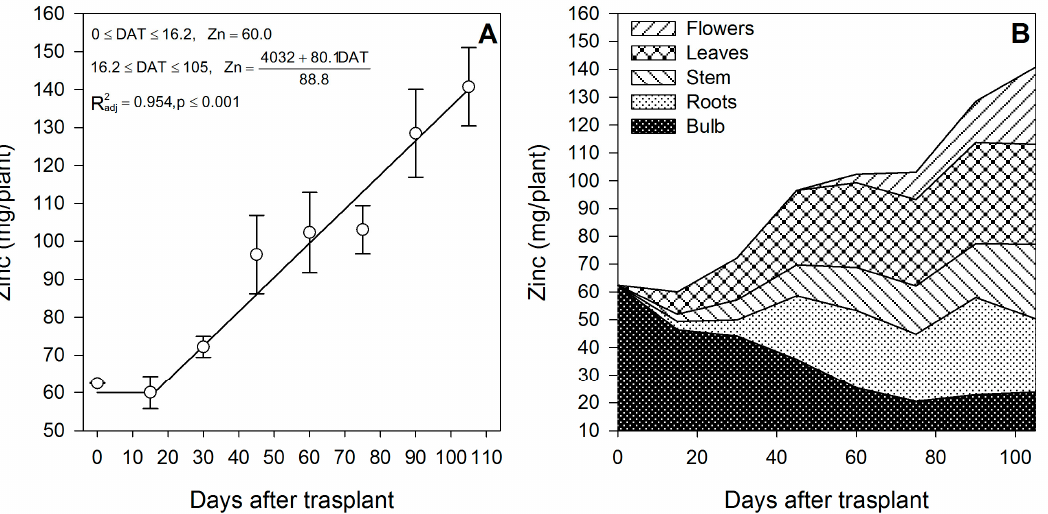
Figure 9. Zinc accumulation in lilium: ( A ) Segmented analysis of phosphorus accumulation over the growing season; ( B ) Phosphorus distribution in the lilium plant parts. Day 0 = transplant day, days 0 to 15 = sprouting and initial vegetative growth, days 15 to 60 = rapid vegetative growth plus flower buds formation, days 60 to 105 = blooming. DAT = days after transplant.